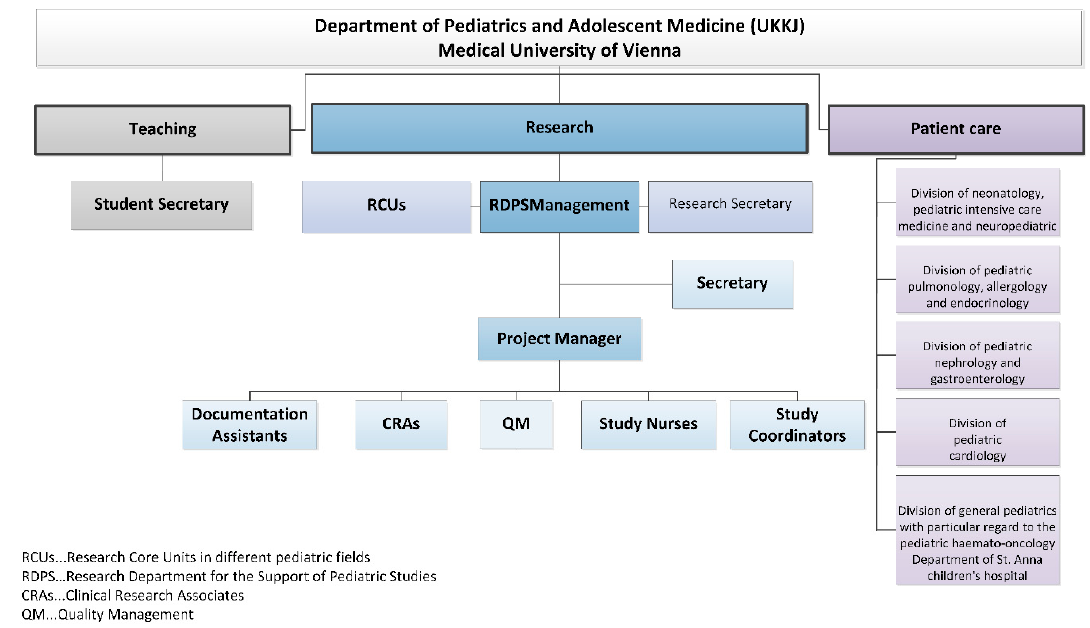
Figure 2. RDPS organizational chart embedded into UKKJ.